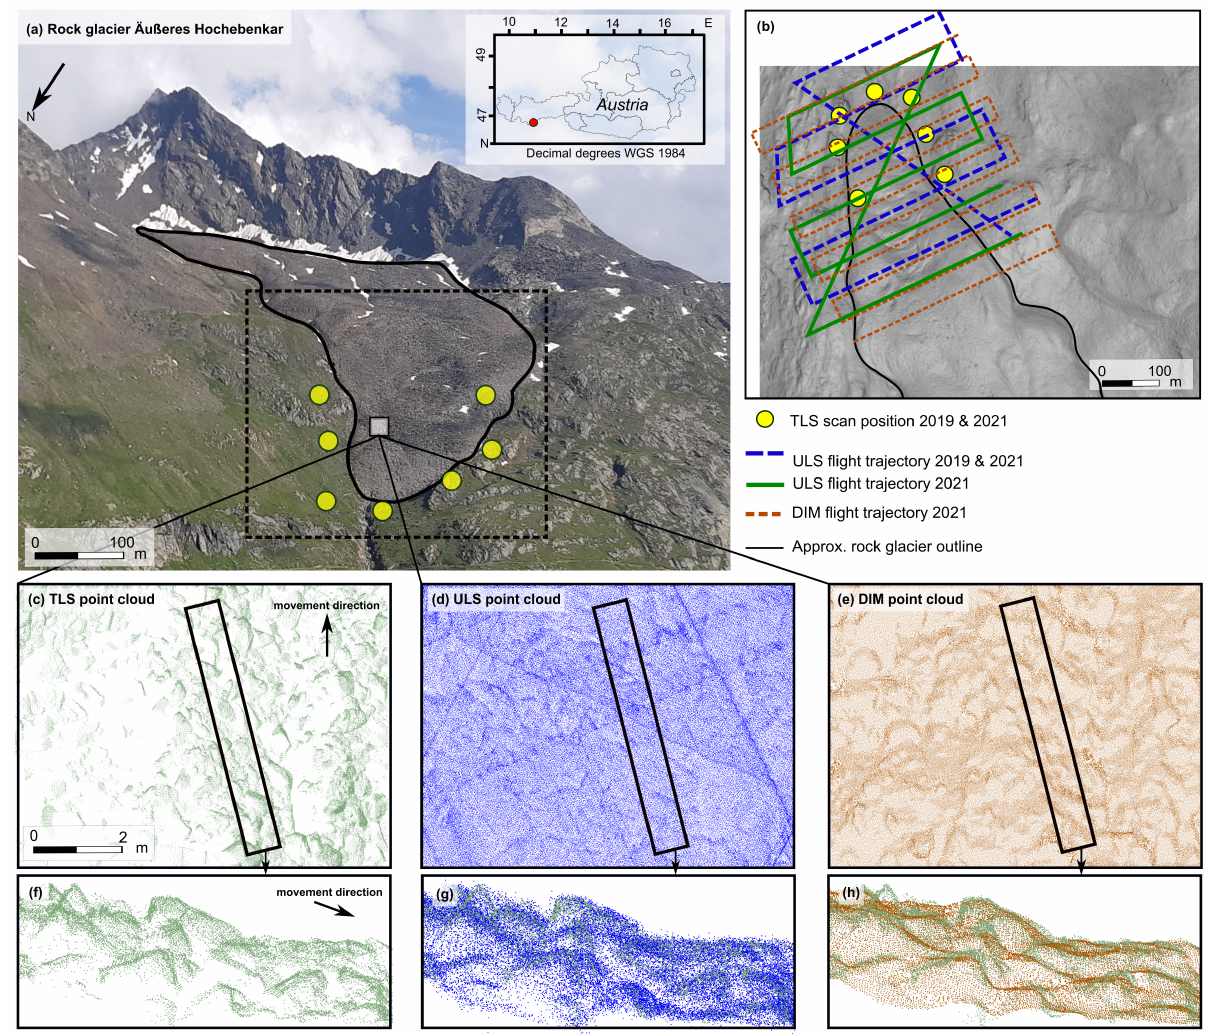
Figure 1. Overview map of the study site in the lower tongue area of the rock glacier ¨Außeres Hochebenkar, Austria. (a) View of the entire rock glacier from opposite site of the valley and locations of terrestrial laser scanning (TLS) scan positions (photo taken in 2020). (b) UAV flight trajectories and TLS scan positions shown on top of a hillshade derived from airborne laser scanning data. (c)-(e) Sampling of the rock glacier surface by point clouds originating from terrestrial laser scanning (TLS, (c)), UAV-borne laser scanning (ULS (d)) and UAV-borne photogrammetry using dense image matching (DIM, (e)) in a subarea of the rock glacier. (f)-(h): Close-up view showing differences in the geometric representation of the surface by TLS, ULS, and DIM point clouds. Smoothing effects introduced during dense image matching are visible in (h).